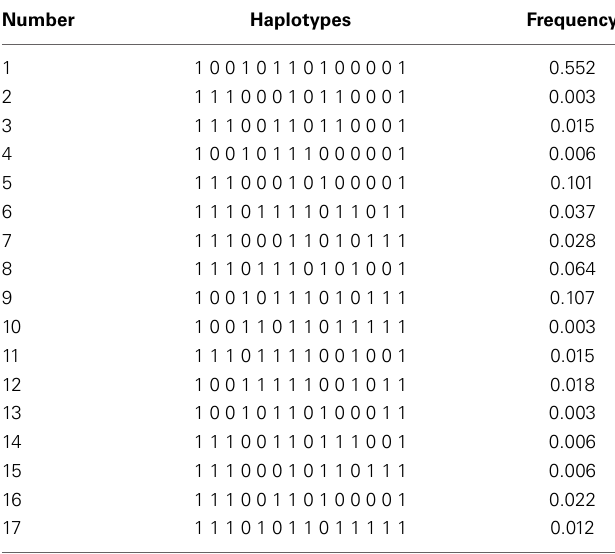
Table 1 | 17 KIR gene haplotypes with their frequencies used in